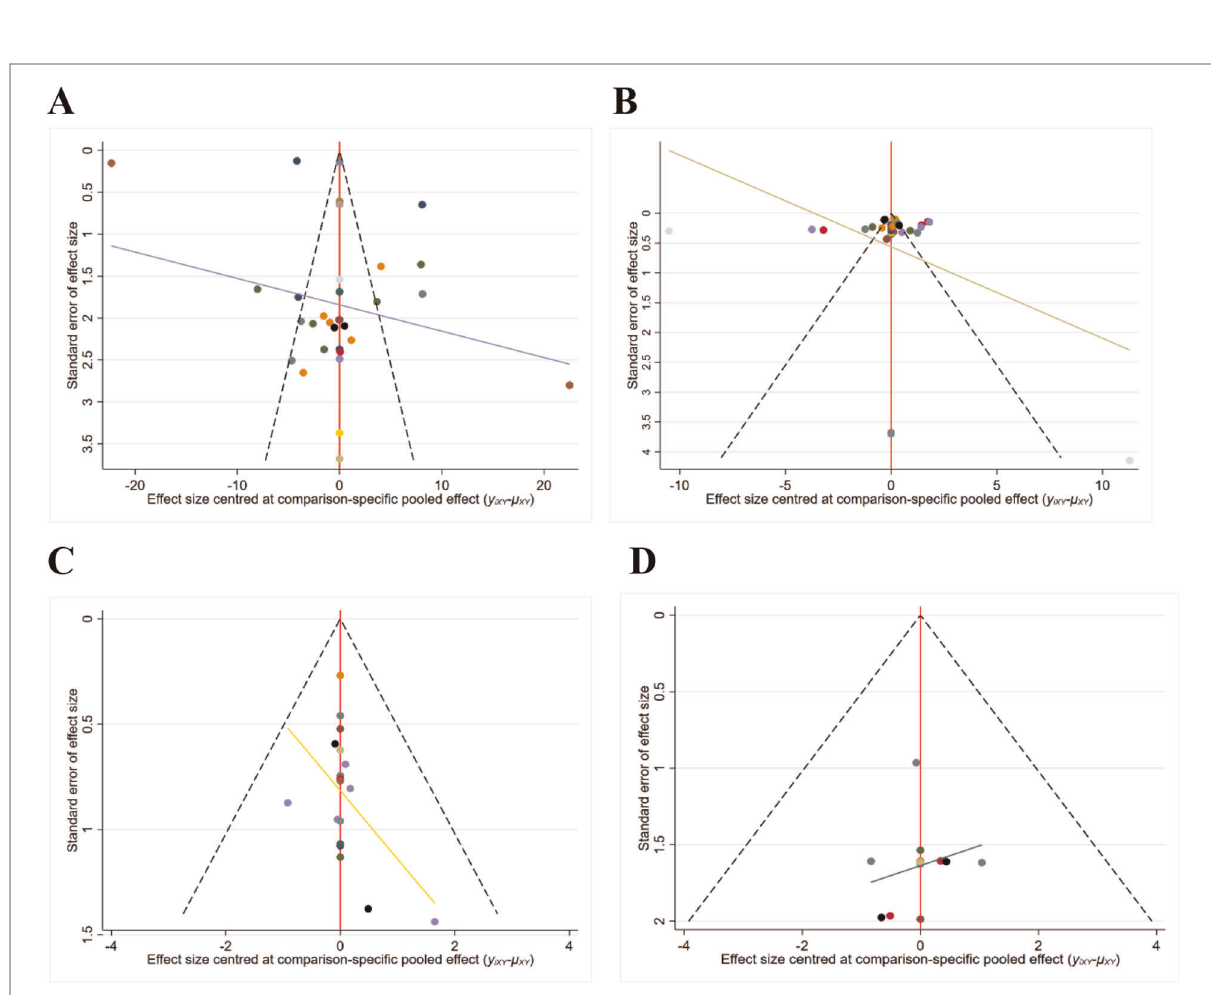
FIGURE 4 The funnel plot of outcome measures. ( A ) Funnel plot for the AOFAS scores; ( B ) Funnel plot for the VAS scores; ( C ) Funnel plot of the total postoperative complication rates; ( D ) Funnel plot of the DVT